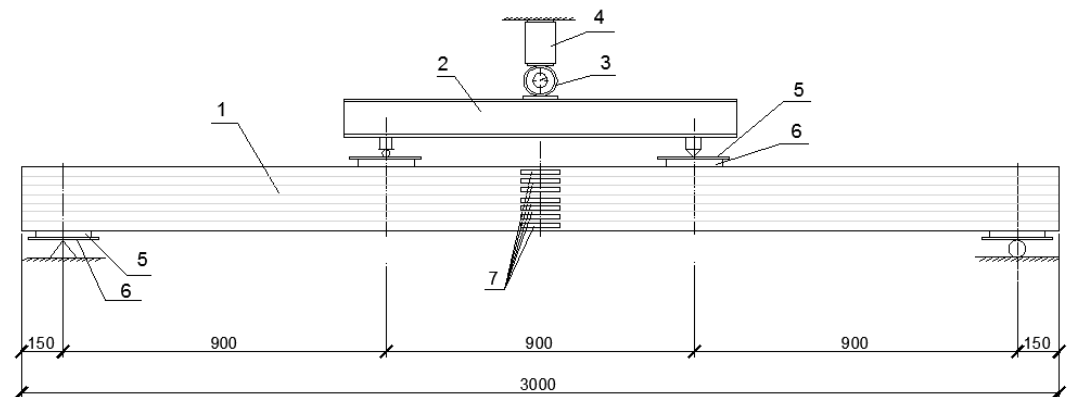
Figure 2. Scheme of experiment plant for testing beams made from glued laminated wood under bending: ( 1 ) studied beam; ( 2 ) metal traverse; ( 3 ) dynamometer; ( 4 ) jack; ( 5 ) metal plate; ( 6 ) wooden plate; ( 7 ) strain sensors.